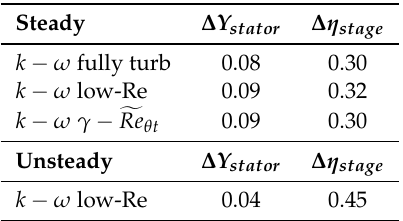
Table 1. Impact of numerical